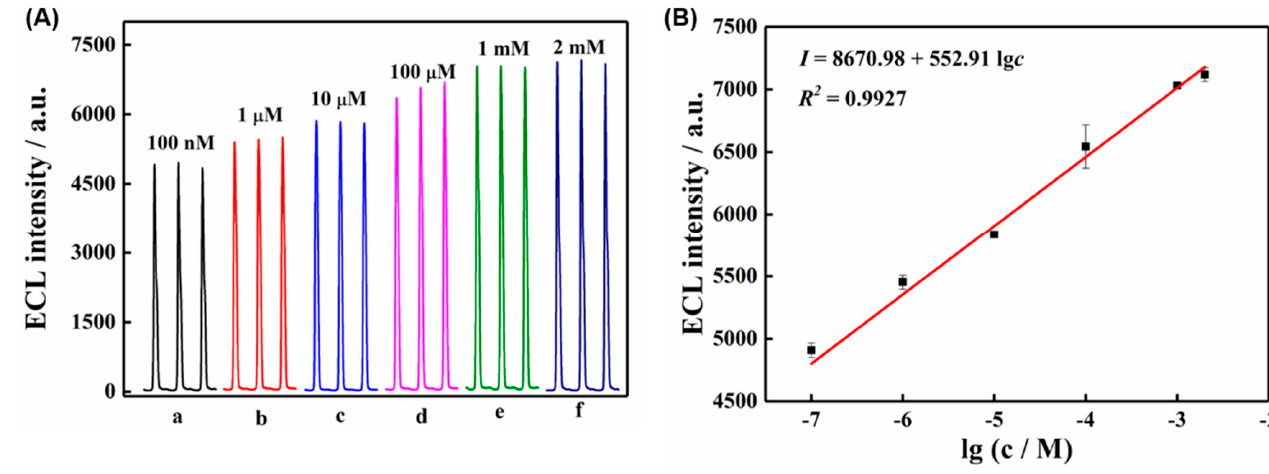
Figure 10. ( A ) ECL response of TCPP-Zn-(S)-BINOL/GCE to L-Tyr of different concentrations. ( B ) Linear relationship between ECL intensity and concentration of L-Tyr.